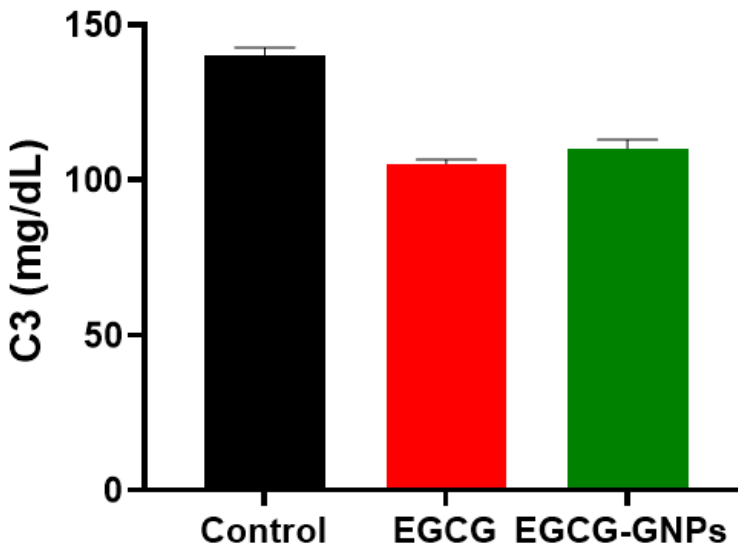
Figure 8. Assessment of the e ff ect of epigallocatechin-3-gallate (EGCG) and epigallocatechin-3-gallate gold nanoparticles (EGCG-GNPs) on the complement component 3 concentration, in vitro. The non-significant decrease in C3 concentration caused by EGCG or EGCG-GNPs confirms the biocompatibility of the prepared EGCG-GNPs.